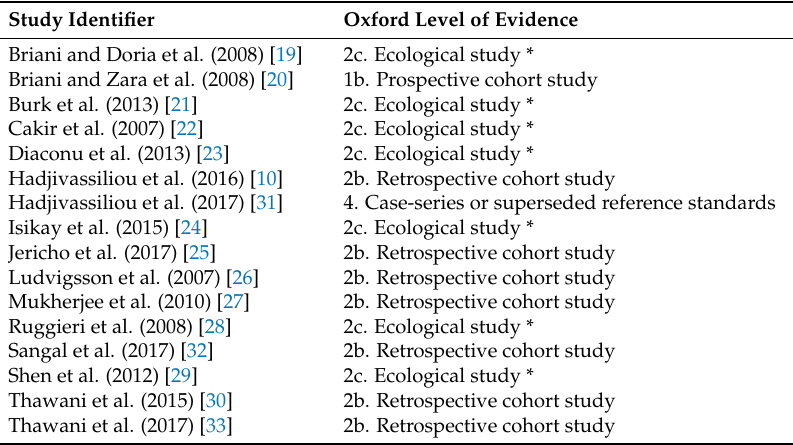
Table 4. Quality Assessment of Included